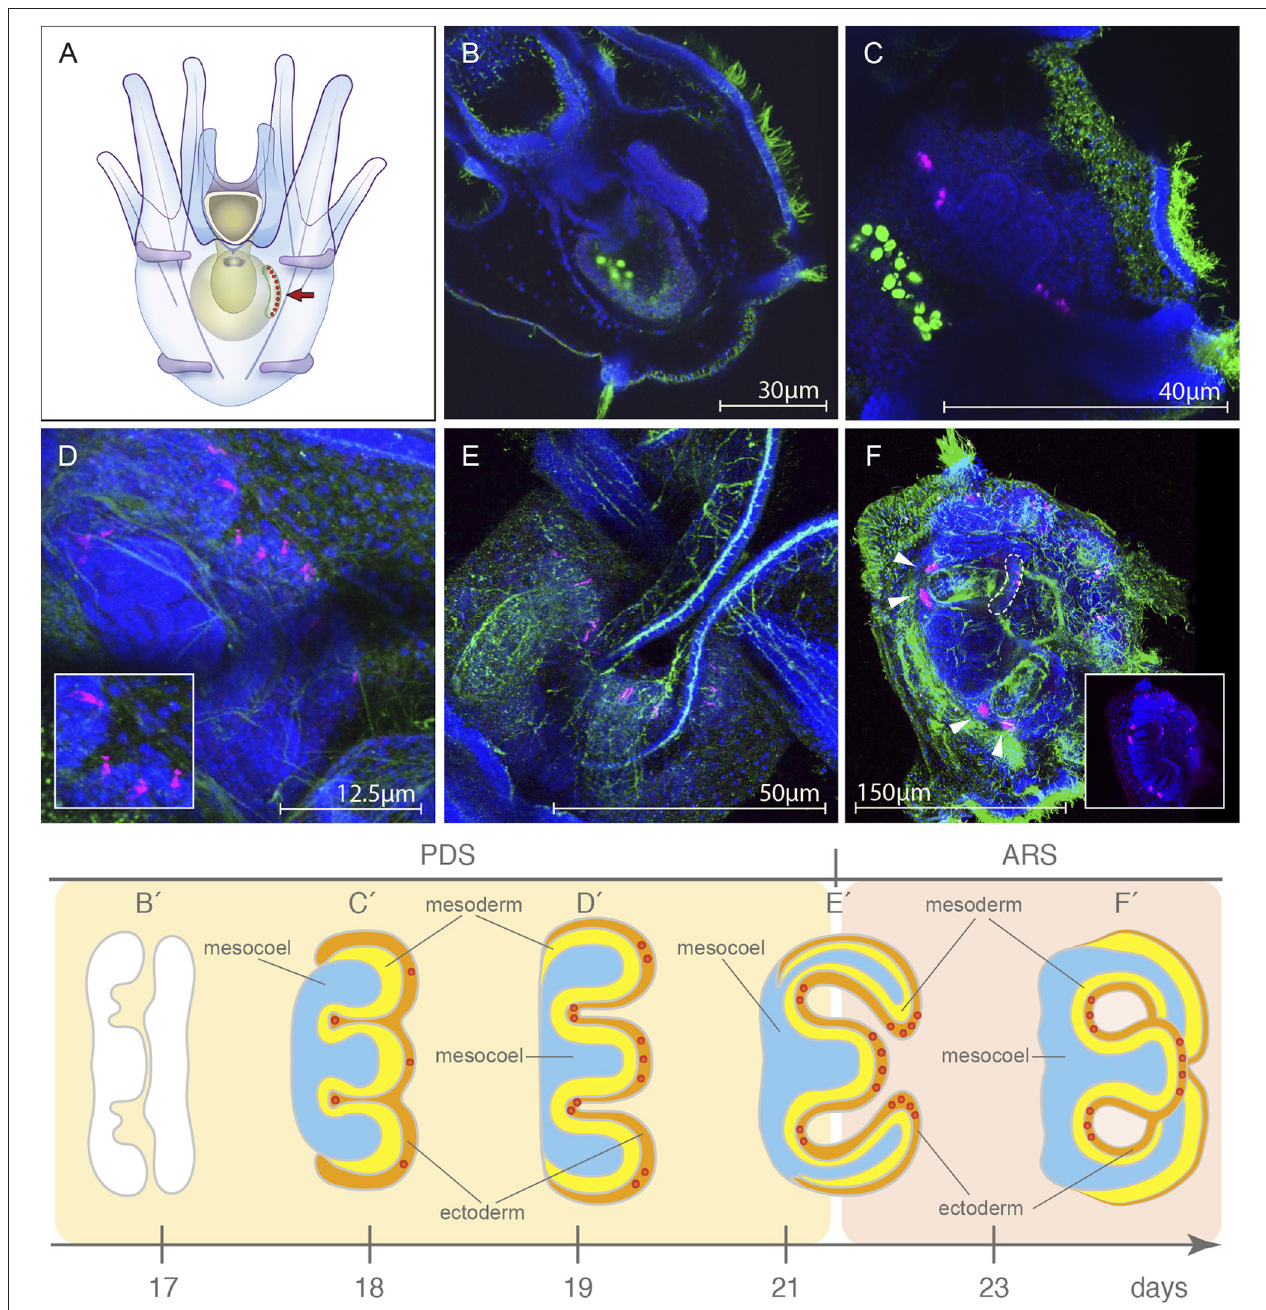
FIGURE 4 | Localization of the rhabdomeric opsin Sp-opsin4 in the developing tube feet of the presumptive juvenile. (A) Schematic of the 8 armed pluteus stage, anal view, in which the area of growing of the rudiment (arrow) is shown. (B,B ′ ) Sp-opsin4 was not detected in adult plate at 5-fold ectoderm stage (day 17; pentagonal disc stage, PDS). (C,C ′ ) During the 5-folding of the ectoderm (day 18, PDS), the rudiment of the larva starts to exhibit Sp-opsin4 positivity in clusters of conspicuous cells at the presumptive basal tube feet. (D,D ′ ) At primary podia stage (day 19, PDS), the presumptive disc tube feet of the vestibular floor are positive for Sp-opsin4. (E,E ′ ) Sp-opsin4 photoreceptor cells are visible in the tube feet disc of the folded primary podia (day 21; transition between the PDS and the advanced rudiment stage, ARS), both in disc and basal photoreceptor cells of the tube feet. (F,F ′ ) Sp-opsin4 positive cells were detected at tube-foot protrusion stage (day 23-45, ARS). Stages redrawn from Heyland and Hodin (2014). PDS and ARS stages are named following the nomenclature proposed by Smith et al. (2008). The red dots in (C ′ -F ′ ) represent the Sp-opsin4 positive cells and can be used as a landmark to locate and orient rudiment in (C–F) . Confocal micrographs color code: Sp-opsin4 in magenta; acetylated α -tubulin (B–E) and 1E11 (F) in green; DAPI in blue. The bright green staining in the stomach of the larvae shown in (B,C) is due to autofluorescence of the ingested microalgae.